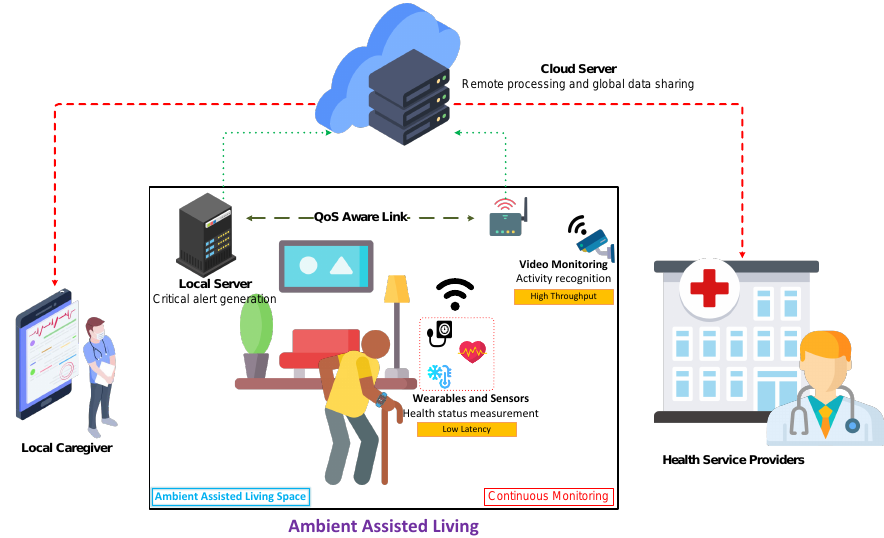
Figure 1. Continuous monitoring of patients in H-IoT: ambient assisted